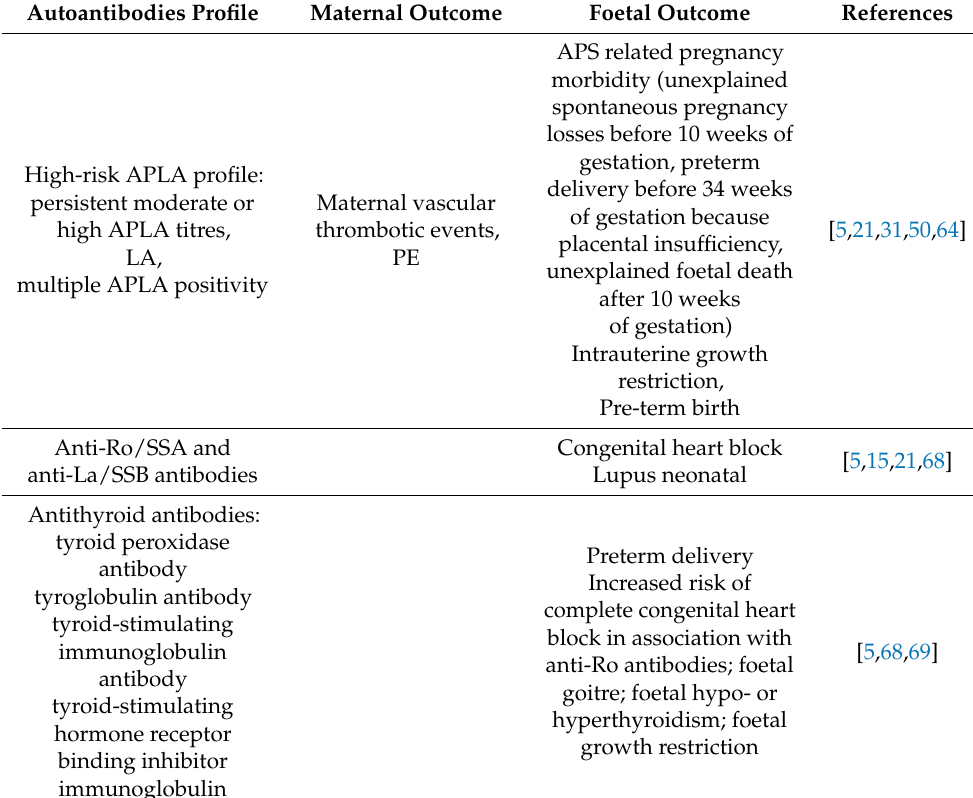
Table 5. Association between different autoantibodies and maternal and foetal outcomes in SLE